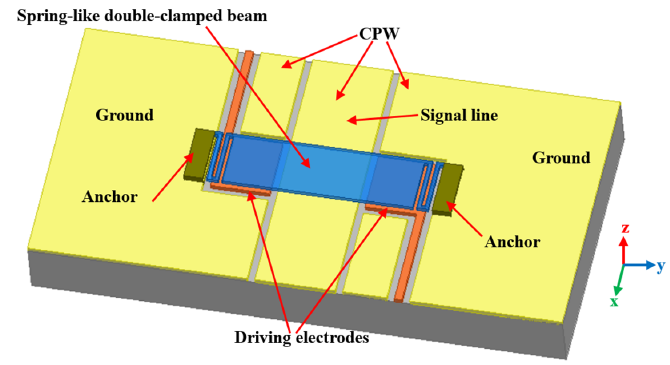
Figure 1. 3-D structure diagram of the double-clamped beam switch.